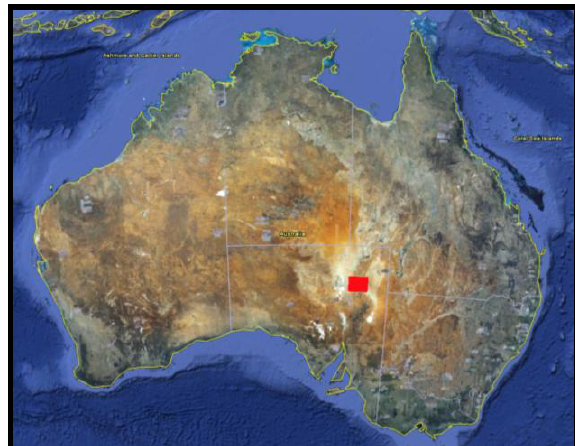
Figure 4. The y-axis shows derived height-to-width ratios (blue) and MODIS NBAR NDVI (green) plotted against the correlation coefficient between NDVI derived from the MODIS BRDF representation and the model (with substituted with best fit values for height-to-width ratio) on the